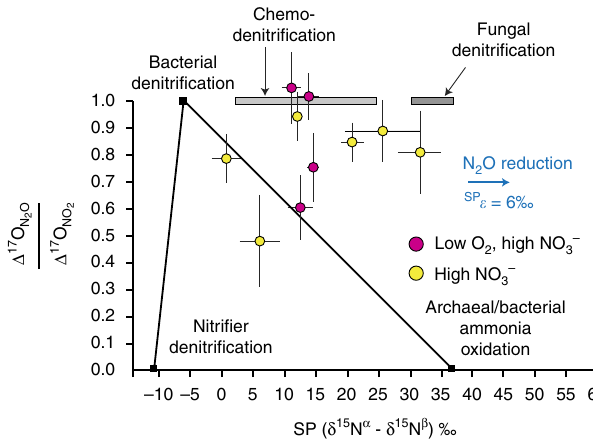
Figure 4 | Comparison of steady state triple oxygen isotope composition of N 2 O and NO 2 (cid:2) with SP N2O for experiments amended with NO 3 (cid:2) . Endmember composition for the y -axis was based on the assumption that Figure 3 | Multiple isotope plot of N 2 O illustrating predicted bacterial, fungal and chemodenitrification are utilizing the steady-state compositional fields of various processes as well as steady-state NO 2 (cid:2) pool as a substrate (where D 17 O NO2 ¼ steady-state value), while composition of N 2 O fluxes from incubations. For illustrating representative nitrifier-denitrification uses only NO 2 (cid:2) derived directly from NH 4 þ oxidation compositional fields of N 2 O production processes (boxes), ranges are taken ( D 17 O NO2 ¼ 0 % ). Increases in SP N2O values may be caused by N 2 O from literature reports of the offset between precursor molecule and reduction (Ostrom et al. 21 ; Jinuntuya-Nortman et al. 86 ), however, this mass predicted N 2 O ( Dd 15 N, or the difference in d 15 N between NH 4 þ and N 2 O for dependent process will only impact SP N2O and not alter D 17 O values bacterial and archaeal ammonia oxidation, between NO 2 (cid:2) and N 2 O for (horizontal arrow). Error bars represent ± 1 s for SP N2O and propagated chemodenitrification or between NO 3 (cid:2) and N 2 O for denitrification). error for D 17 O N2O / D 17 O NO2 . Data demonstrate that associated increases in References (in parentheses) include for (A) bacterial denitrification 20,83,84 , SP N2O upon elevated NO 3 (cid:2) is not associated with ammonia oxidation, but instead is linked to increased contribution of fungal and/or fungal denitrification 37,42–44 and (G) bacterial N 2 O reduction 21,22,86 , which has been shown to result in a coupled increase in d 15 N and SP of the remaining N 2 O pool (indicated by arrows). Experimental x -axis data are d 15 N NO3 – d 15 N N2O . Error bars in the y -direction are 1 s.d., while in the x - direction error is smaller than the symbols. Note that for mass balance calculations the actual measured steady-state isotope values of precursor molecules (for example, NH 4 þ or NO 3 (cid:2) ) were used as appropriate for constraining endmember values of each process. In general, addition of B 100 m M NO (cid:2) to the overlying water increased N 3 2 O fluxes with an accompanying increase in N 2 O site preference, while not decreasing the Dd 15 N (as would be expected from N 2 O reduction, arrows), implicating an increased production of N 2 O from a process deriving from NO 3 (cid:2) (or NO 2 (cid:2) ) yet also one yielding an elevated site preference such as chemodenitrification and/or fungal denitrification.